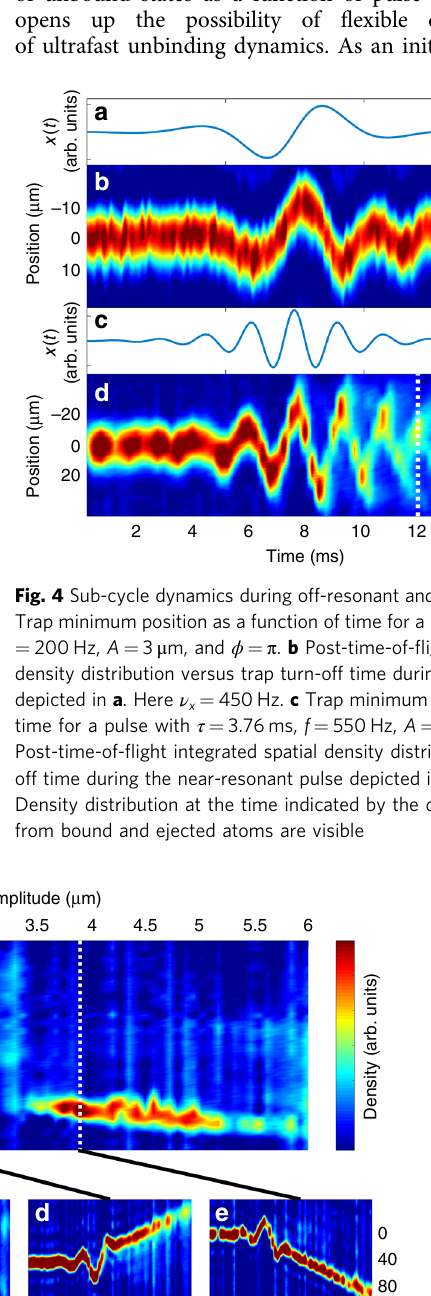
Fig. 5 Dependence of unbinding dynamics on pulse amplitude. a Integrated spatial density distribution after application of a near-resonant 480 Hz pulse with τ = 3.76 ms and ϕ = 0 followed by 2 ms time of fl ight, versus pulse amplitude A . b – e Integrated spatial density distribution versus time during pulses with the indicated amplitude. Panels d and e have an expanded y -axis (indicated at right) to track the unbound atoms. Note the momentum of the unbound atoms changing sign as the pulse amplitude